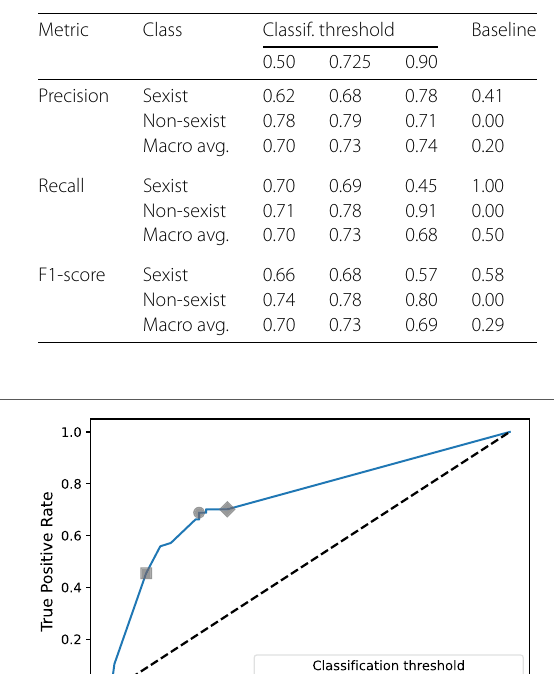
Table 4 Performance of the sexism classifier on the external dataset for three classification thresholds and N B = 1. Metrics for both classes (Sexist and Not sexist) and the corresponding macro average are shown. Right column shows the performance of a naive baseline that always predicts the sexist class